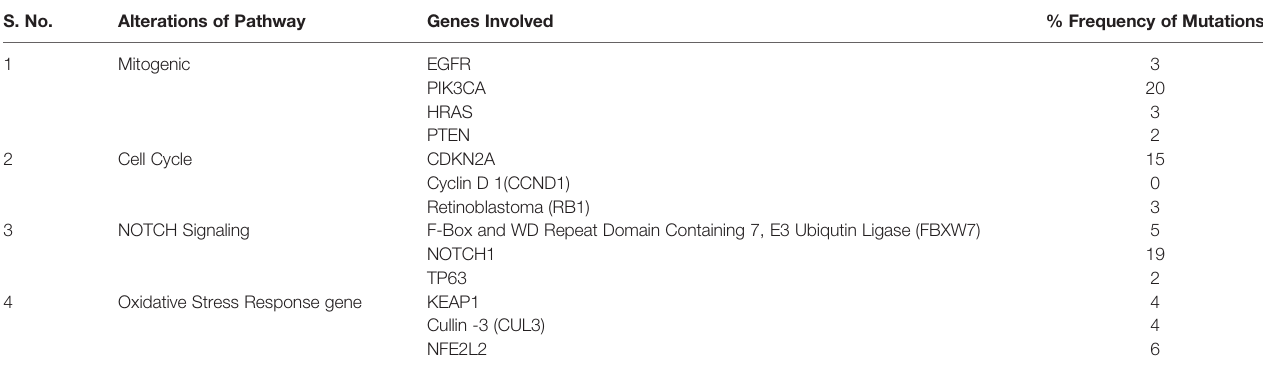
TABLE 5 | Alterations in key pathways in head and neck squamous cell